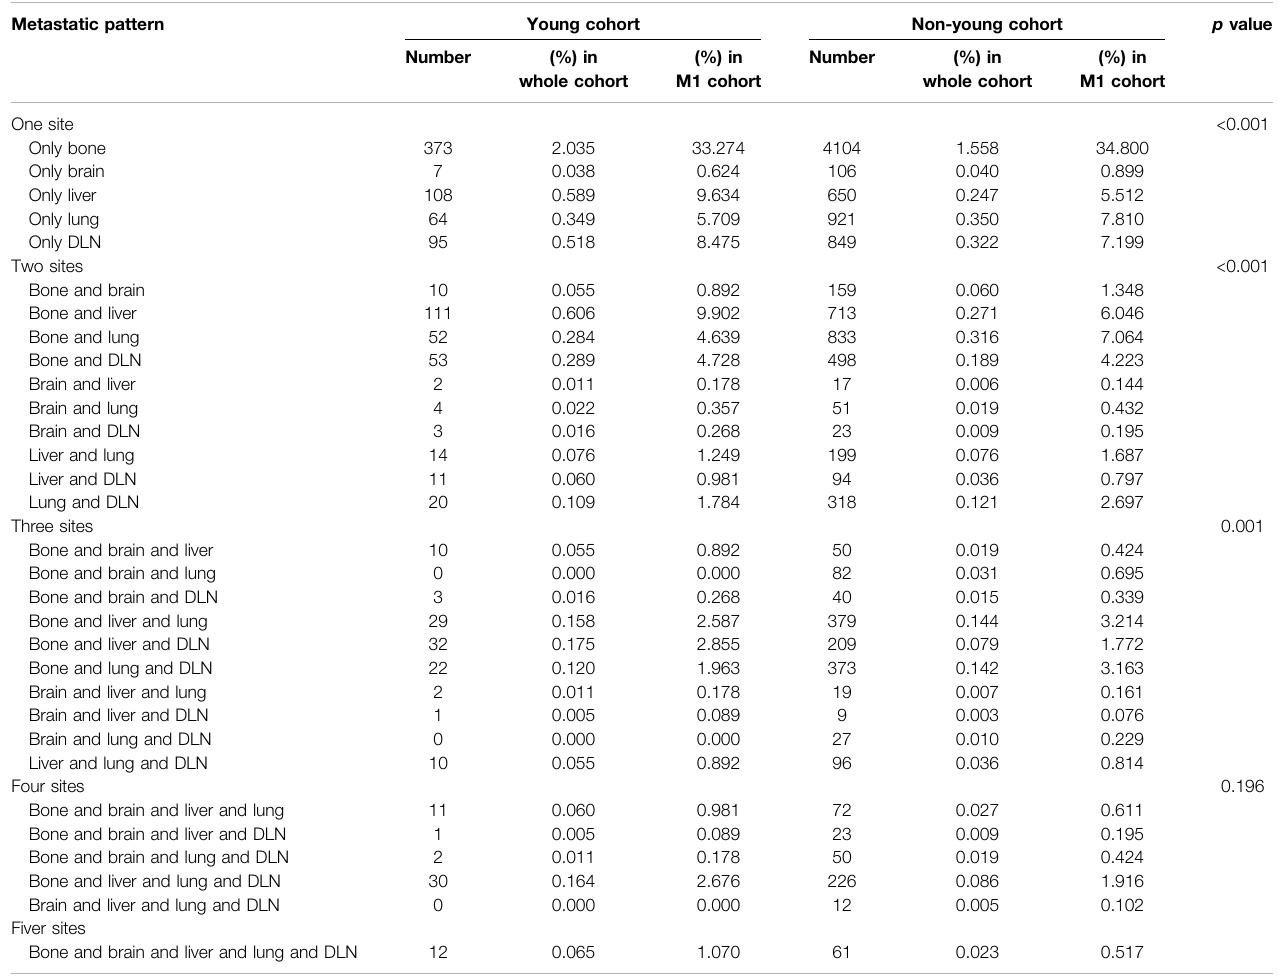
TABLE 2 | Frequencies of metastatic pattern. Metastatic